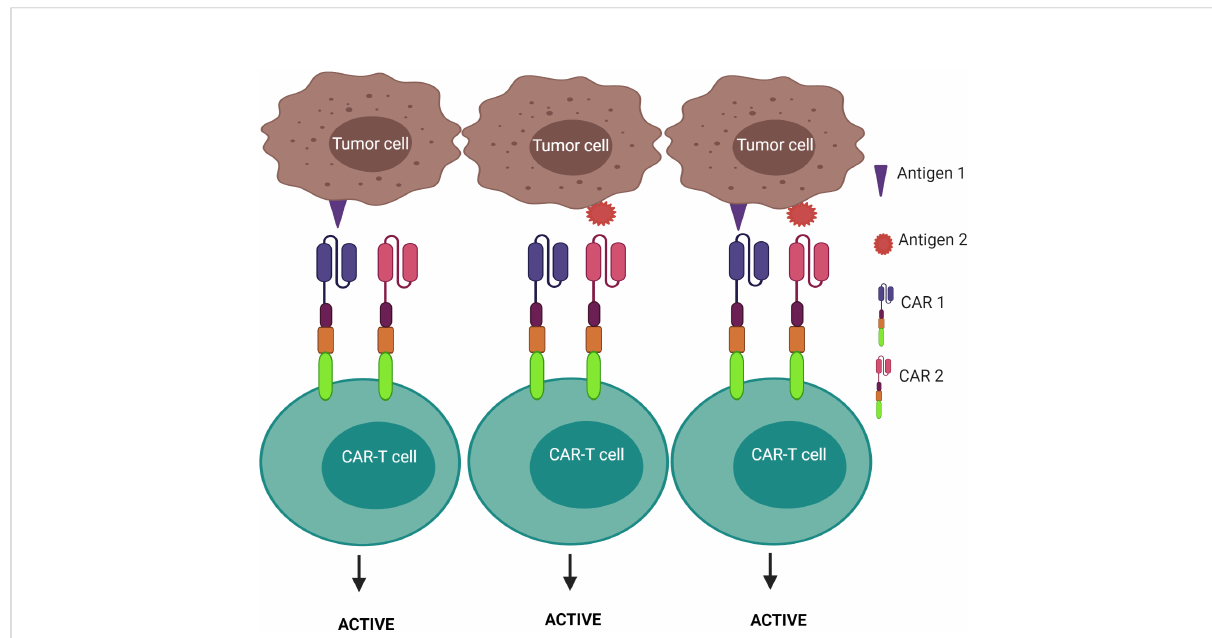
FIGURE 7 “ OR ” logic-gated CAR-T cells for improving the coverage of tumor population and preventing tumor escape. CAR-T cell activation is triggered when either antigen 1 or antigen 2 is encountered.